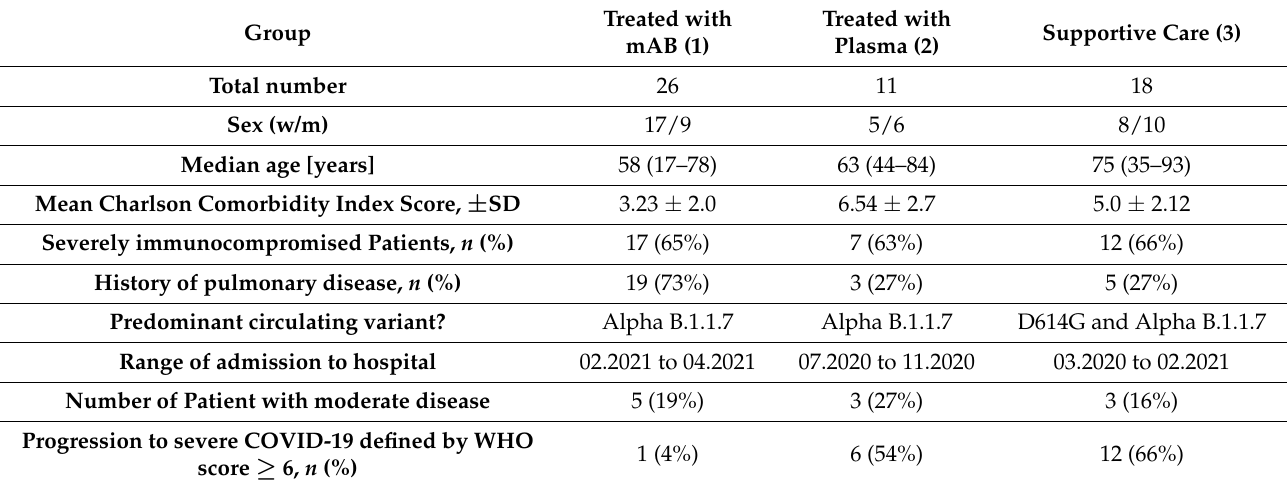
Table 1. Demographic and clinical overview of the study